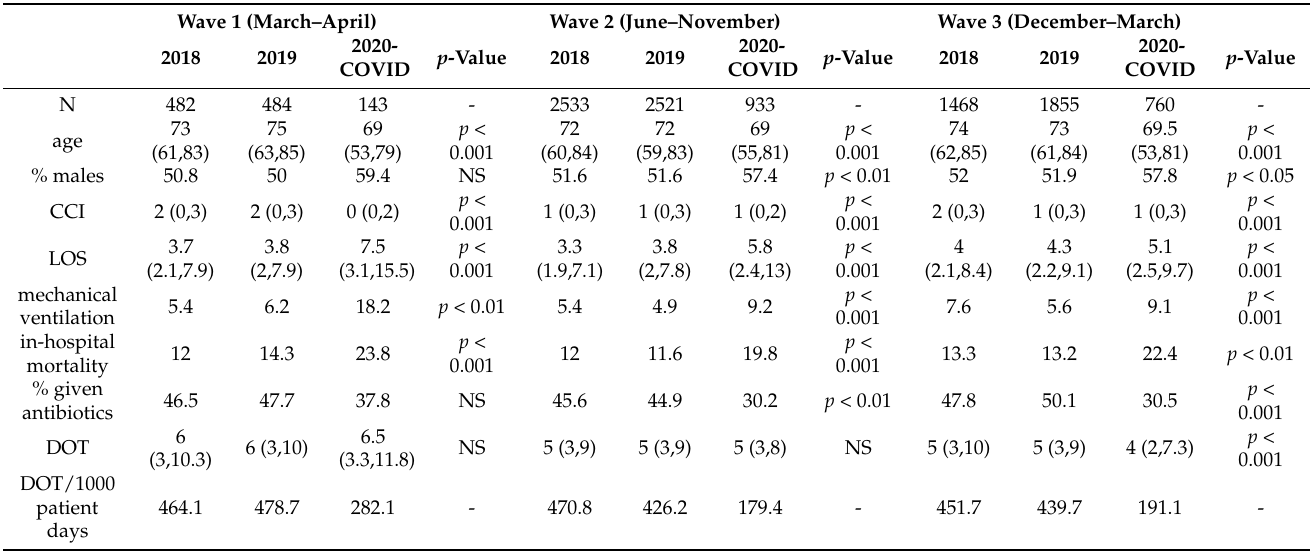
Table 1. Medical COVID-19 departments (2020–2021) vs. equivalent wards in 2018 and